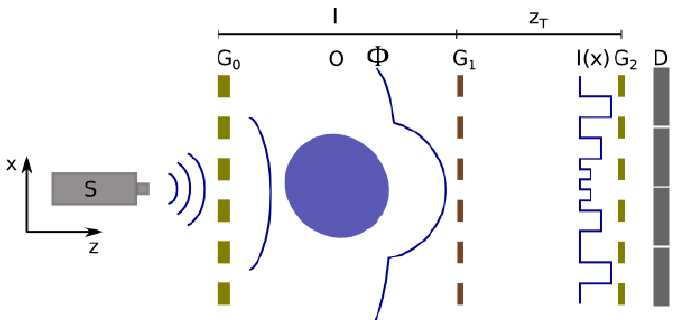
Figure 1. Setup of a Talbot–Lau interferometer. The object O deforms the X-ray wave front emitted by the source S . Because of the Lau and the Talbot effect (due to the gratings G 0 and G 1 ), a periodic intensity pattern can be observed in a Talbot distance z T downstream of G 1 . The period of the intensity pattern is small compared to the size of the detector pixel. In order to scan the pattern, a third grating G 2 has to be placed in a Talbot distance of G 1 in front of the detector. It is used either to sample the intensity pattern in conventional Talbot–Lau imaging or to generate a moiré pattern that can be resolved by the detector. The distance l can be be determined applying the intercept theorem. The detector pixels are usually much larger than the period of the intensity